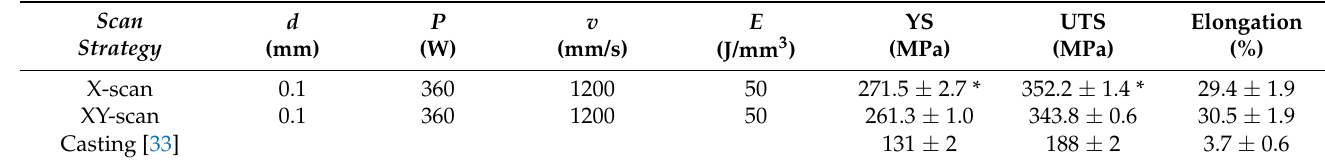
Table 2. Laser parameters, yield strength (YS), ultimate tensile strength (UTS), and elongation of the